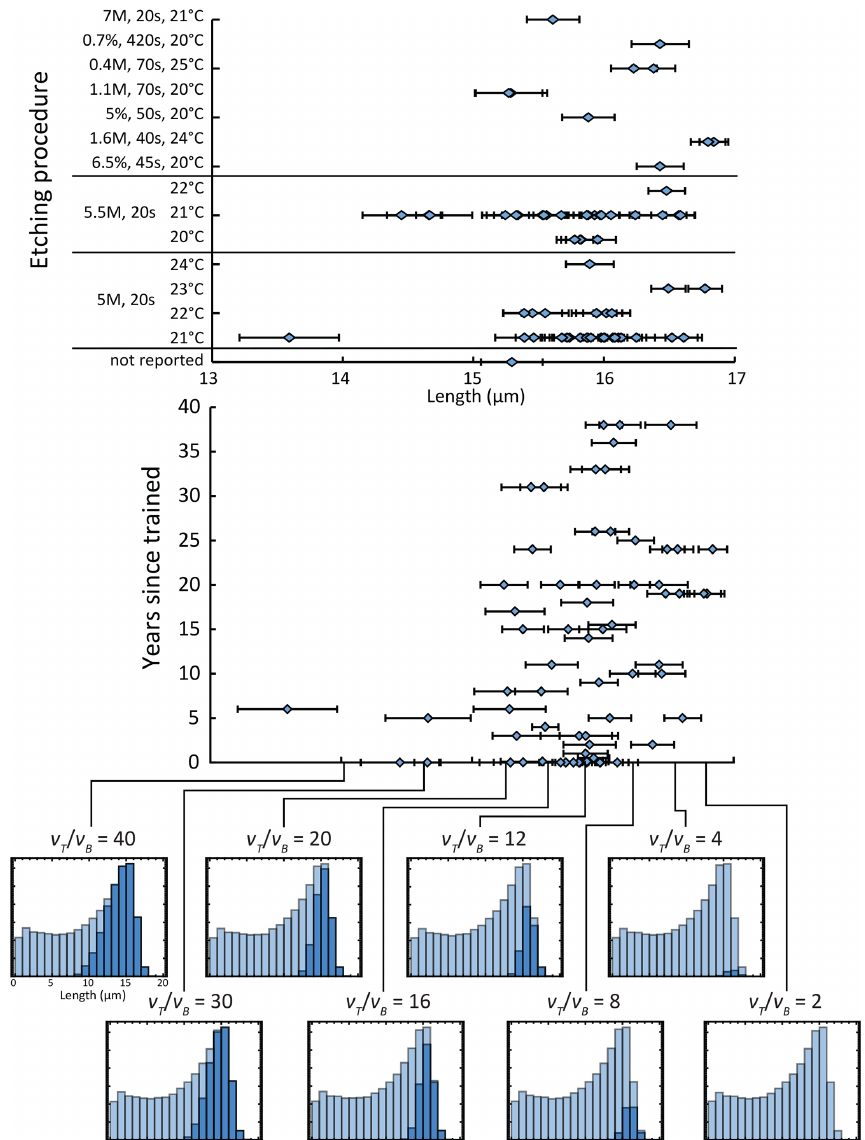
Figure 17. Upper graphs (based on Ketcham et al., 2015, Fig. 2c, d) show results of an inter-laboratory exercise measuring unannealed induced tracks in Durango apatite against etching procedure (upper graph) and years since being trained in fission-track analysis (middle graph). Histograms below show the prediction of a constant-core v T ( x ) model, varying only required v T /v B for track selection; light bars are unselected tracks, and dark bars are selected